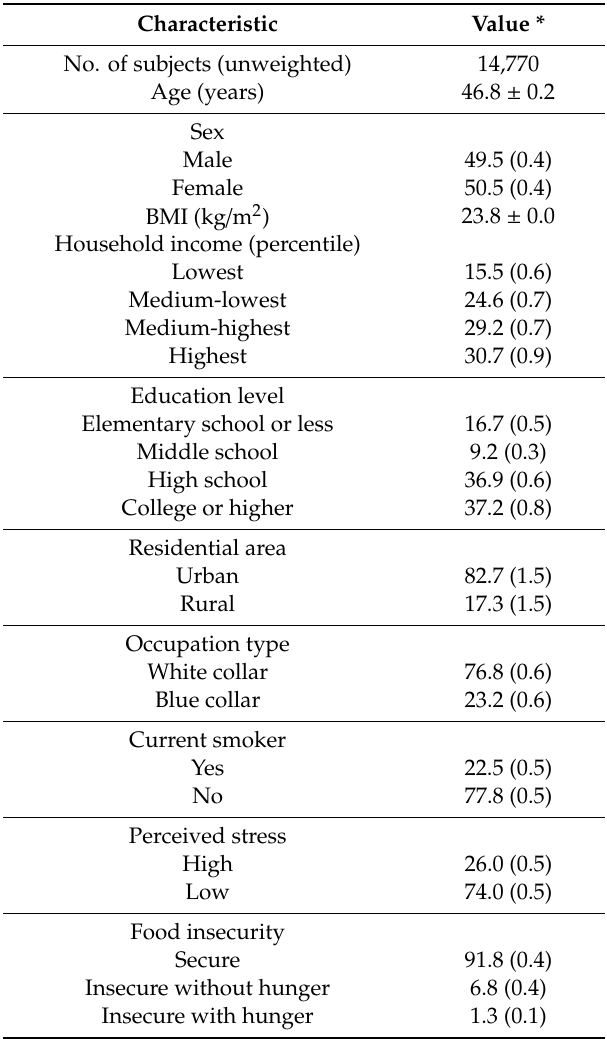
Table 1. Subject